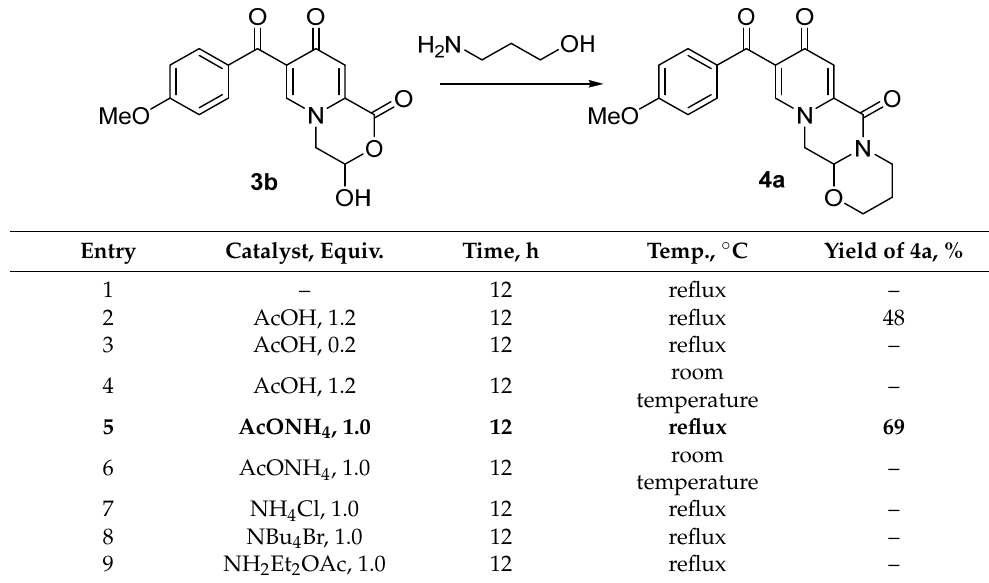
Table 2. The optimization of reactions conditions for the synthesis of 4a from 3b and 3-aminopropan-1-ol a .